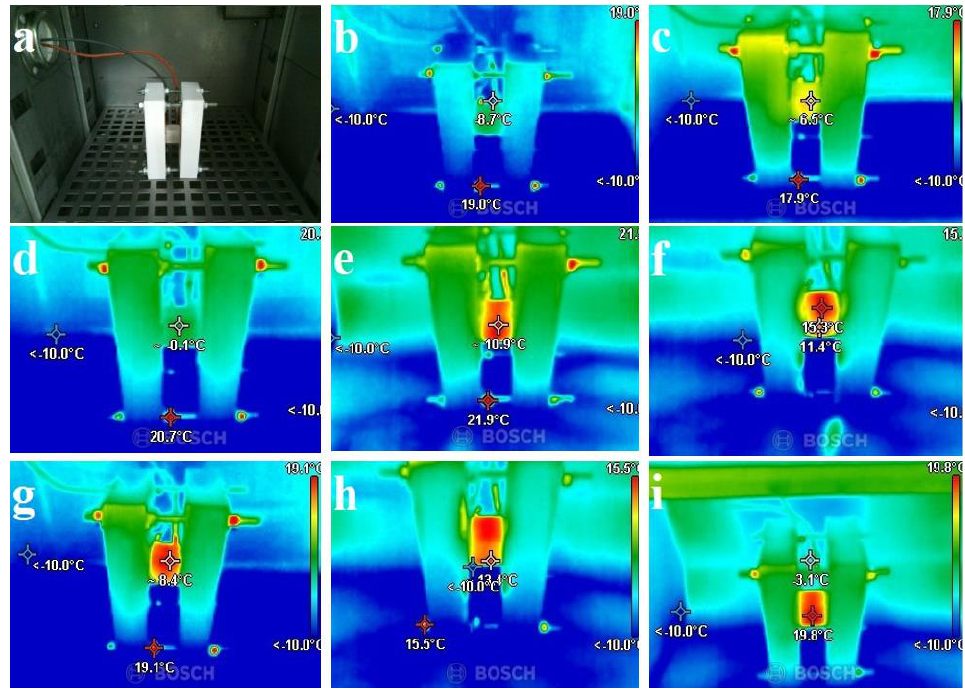
Figure 7. Digital images of the experimental cell setup within the climatic chamber ( a ), and thermal images of concrete blocks filled with CNFs ( b , c ), GLC ( d – f ), and CNF/GLC composite ( g – i ) .